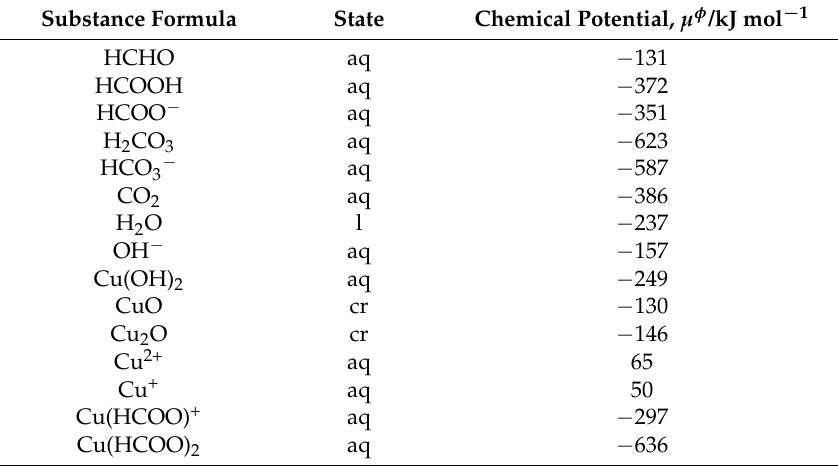
Table 1. Thermodynamic data (1 atm, 298